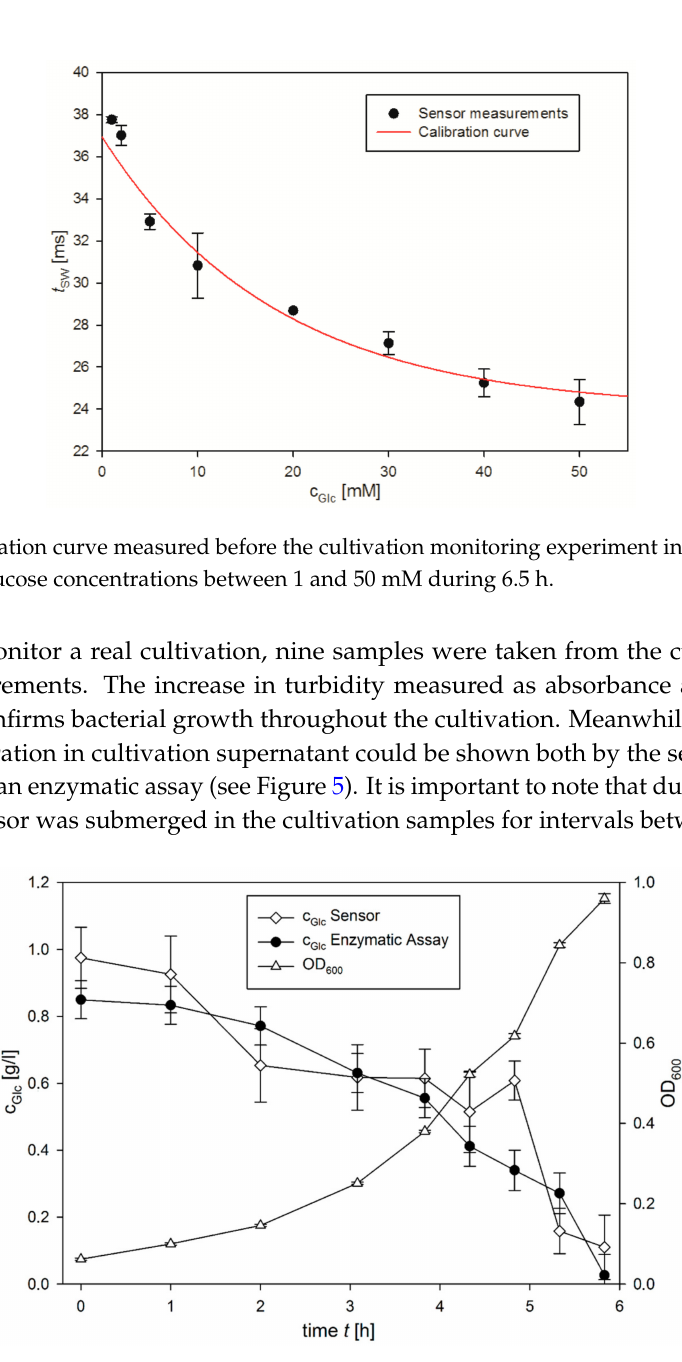
Figure 5. Growth curve of a BL 21 Escherichia coli cultivation in Noack medium. The cell growth was monitored by optical density at 600 nm (OD 600 ). For glucose measurements, samples were removed from the cultivation and analysed with the glucose sensor and a commercial enzymatic glucose hexokinase